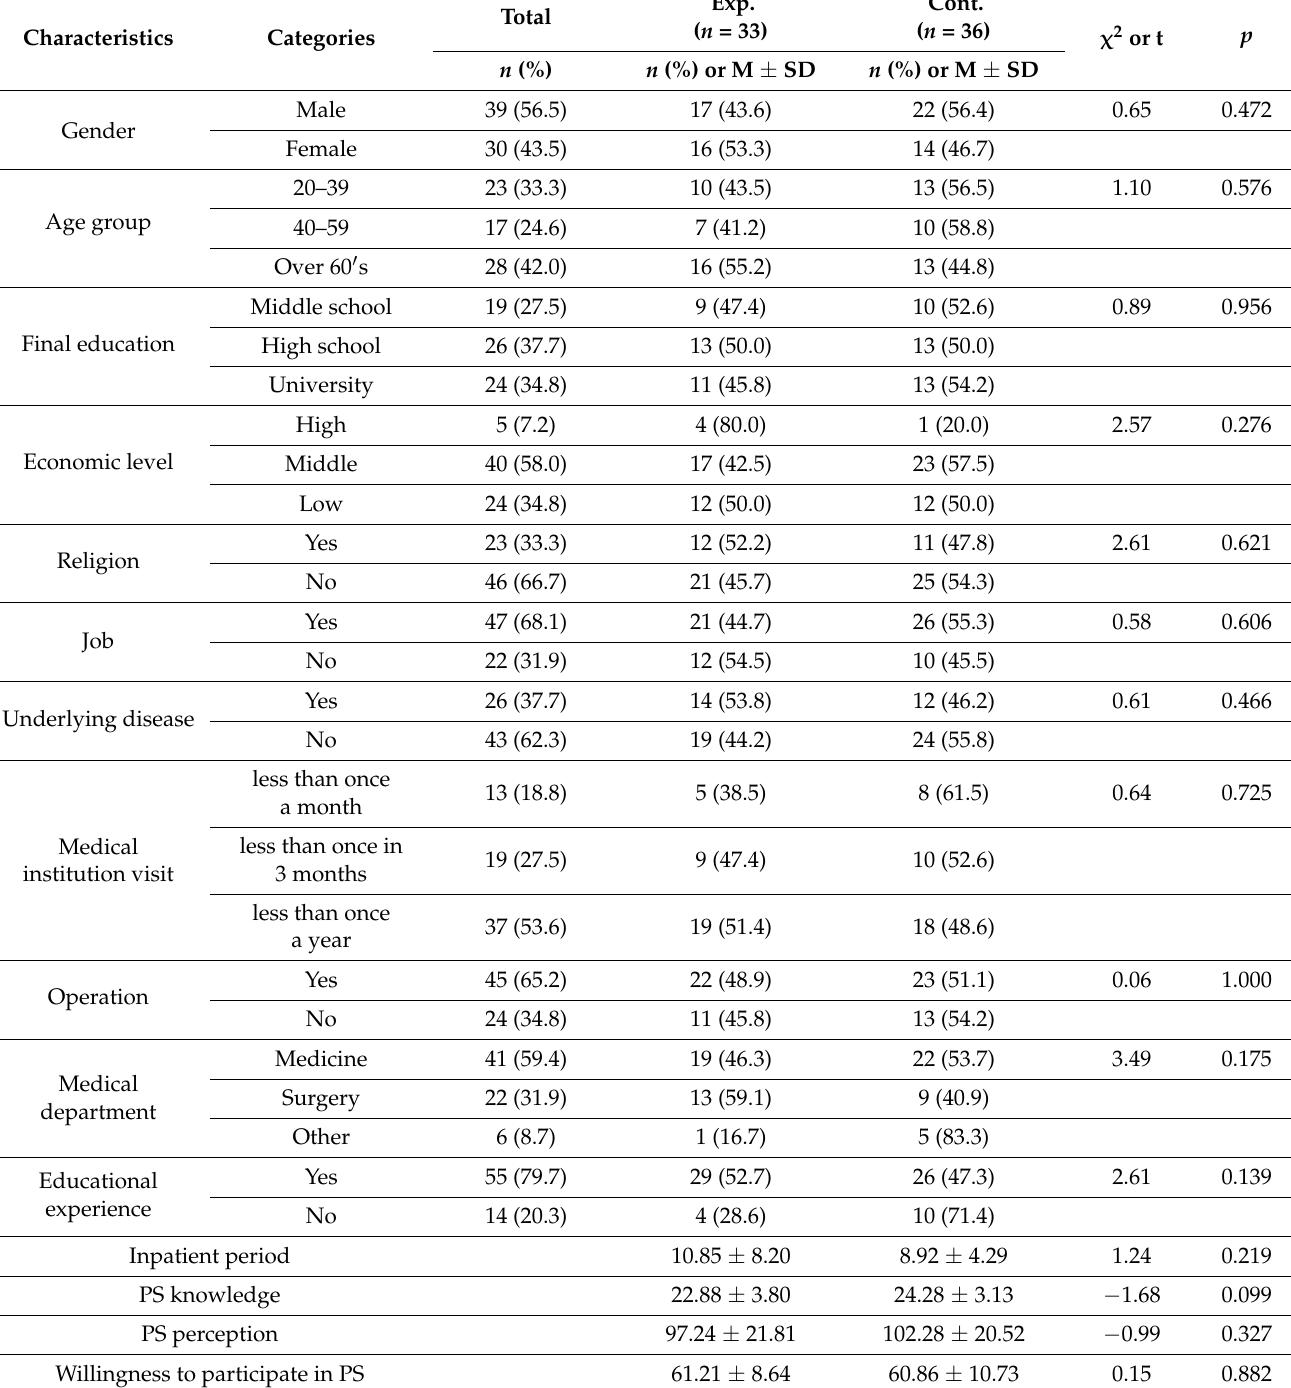
Table 3. Homogeneity test between experimental and control group ( N =